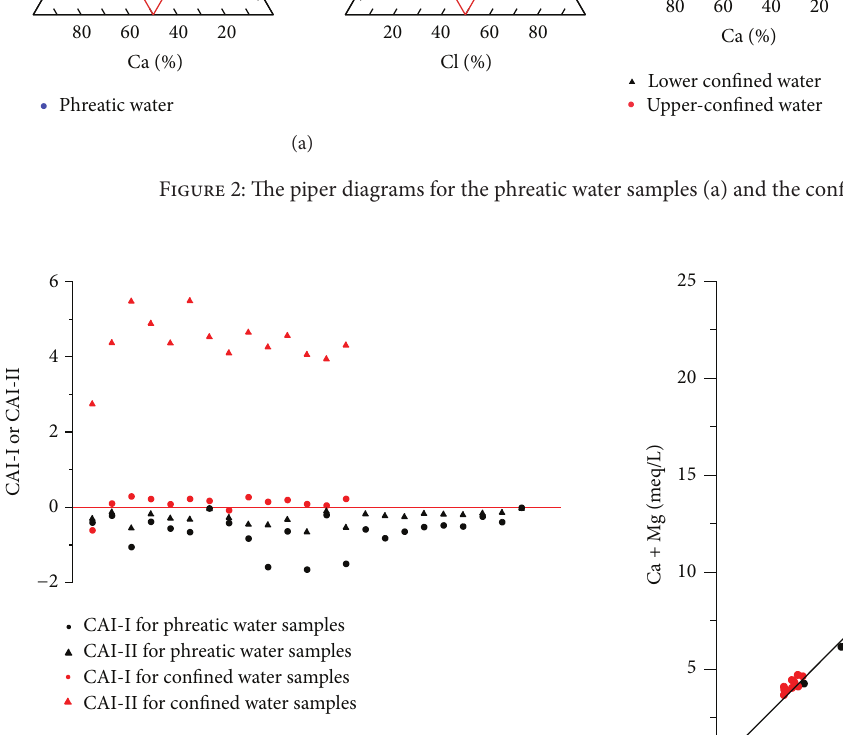
Figure 3: Chloroalkaline indices (CAI-I and CAI-II) for the phreatic water samples and the confined water samples.